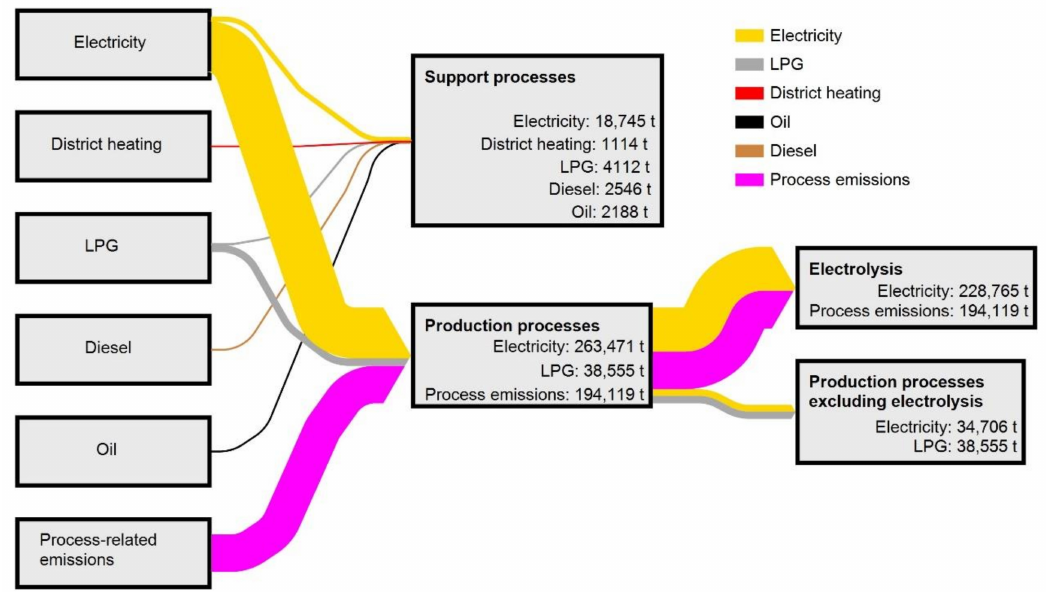
Figure 7. The GHG emissions of the aluminium industry and two aluminium casting foundries in Sweden, divided into support and production processes. For production processes, the GHG emissions for electrolysis are also shown. The average mix perspective and the emission factors in Table 1 were used here, as described in Section